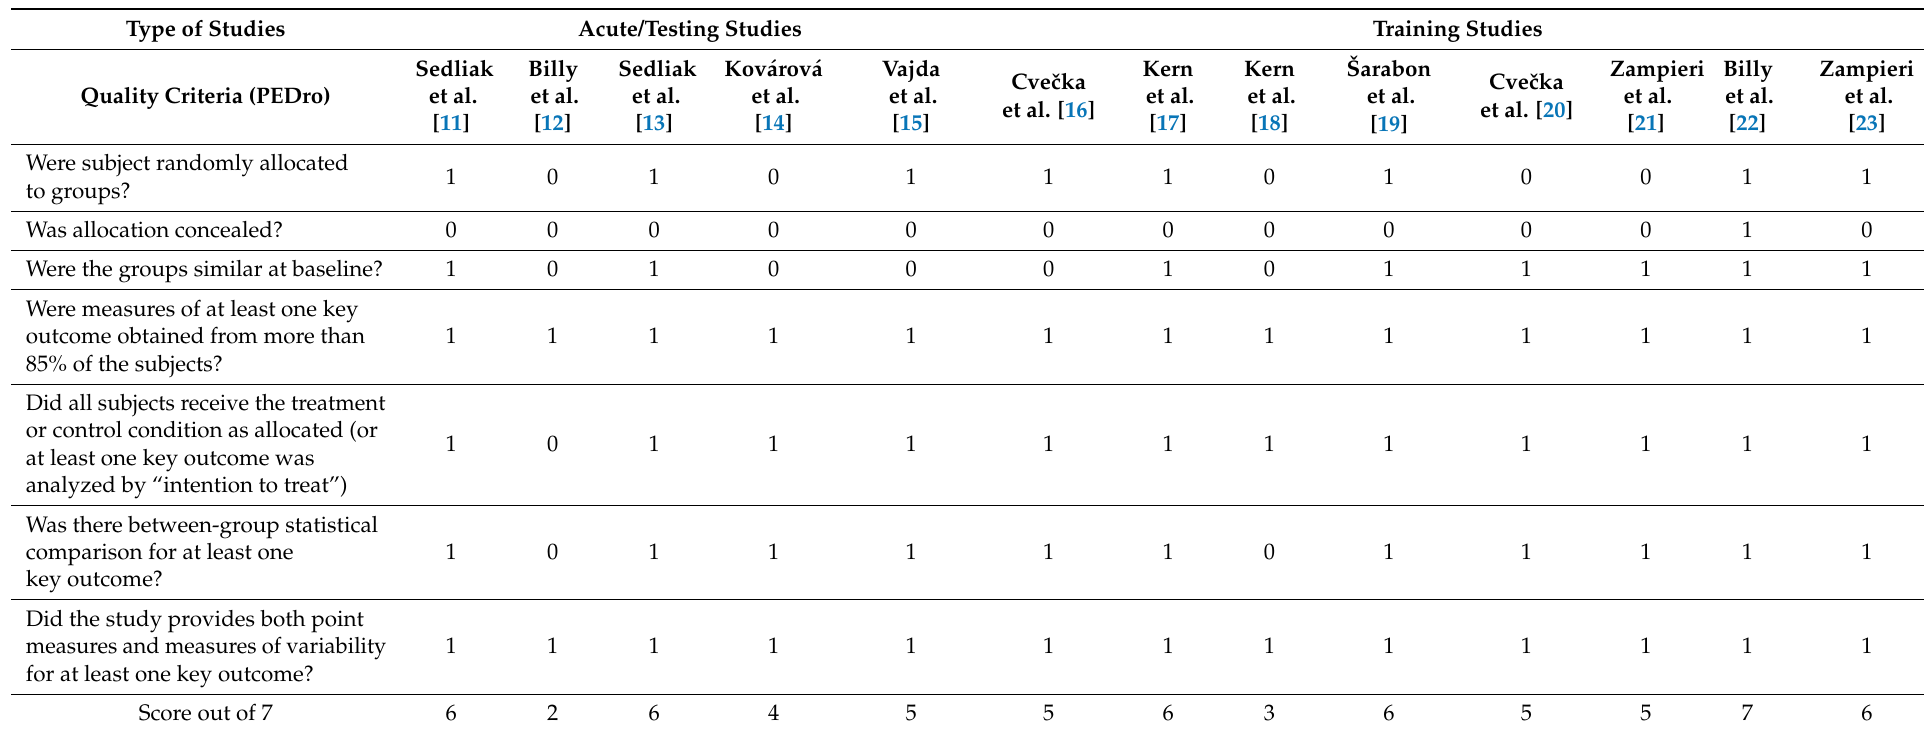
Table 1. Qualitative evaluation of the selected studies. Training and acute/testing studies are